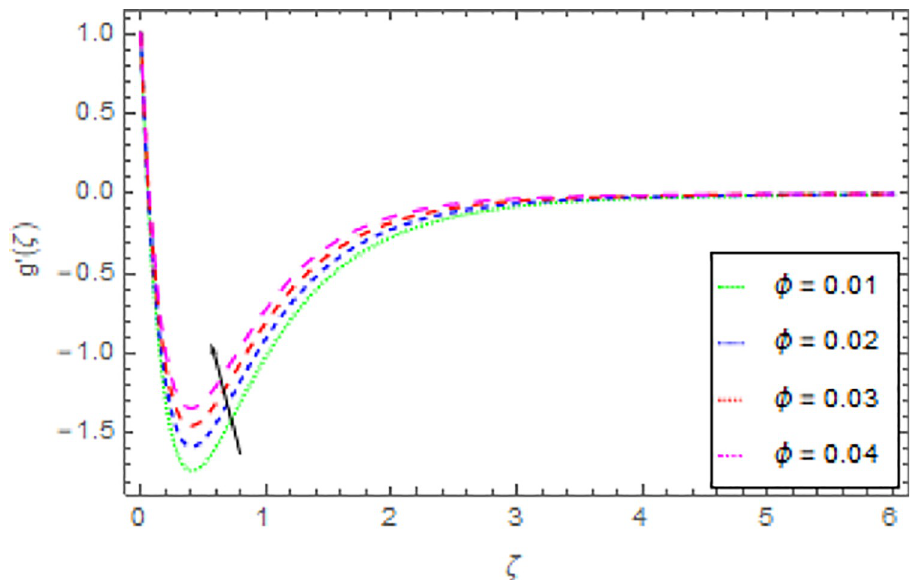
Fig 9. Deviation in nanofluid velocity ( y − direction) against ϕ Pr = 1000, m = 0.10, n = 1.00, M = 2.50, δ = 0.40, β = 1.00 and Nr =